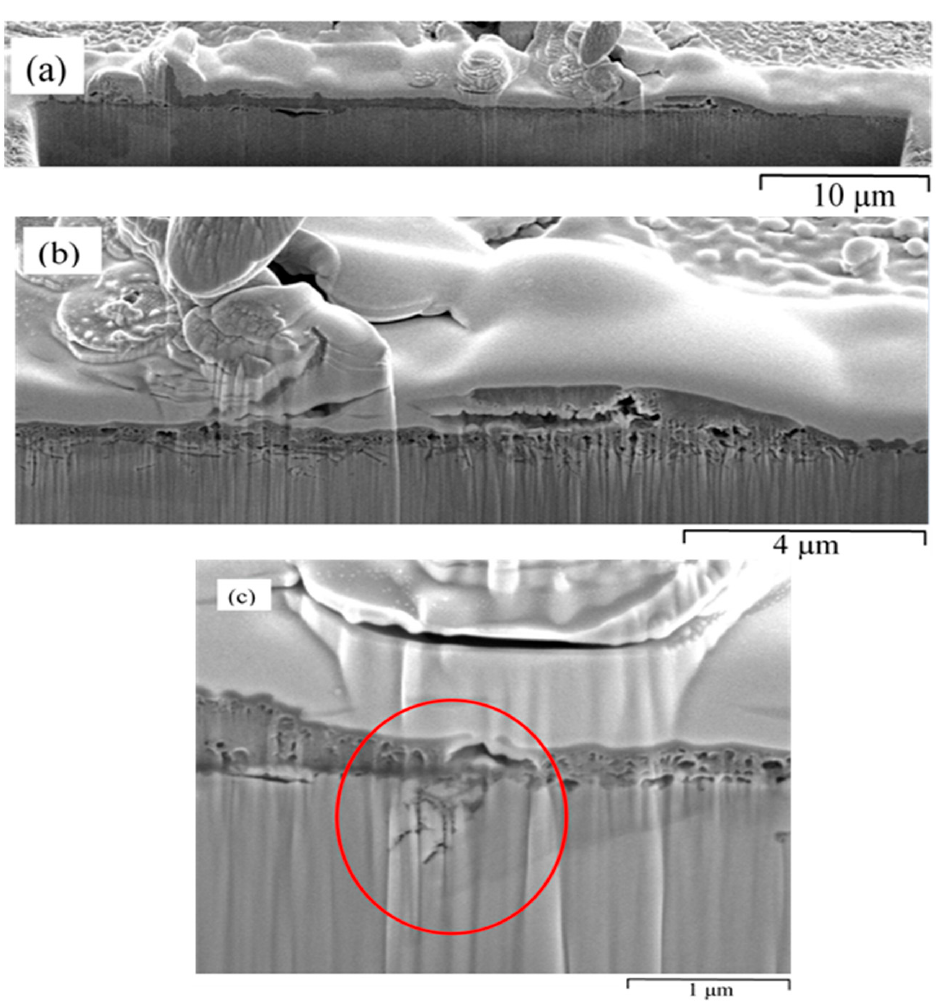
Figure 12. FIB-SEM cross-sectional analysis of biofilm formed on carbon steel by pure culture of IRB in inorganic medium following a 72 h exposure: ( a ) overview of the biofilm cross-section, and ( b , c ) the extent of cracking attack observed under the IRB biofilm at higher magnification.